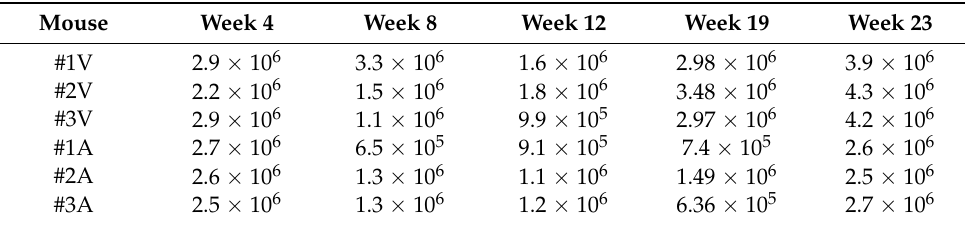
Table 1. Viral DNA copy numbers in vaginal (V) and anal (A) tracts of three mice infected with wild-type MmuPV1 over time.